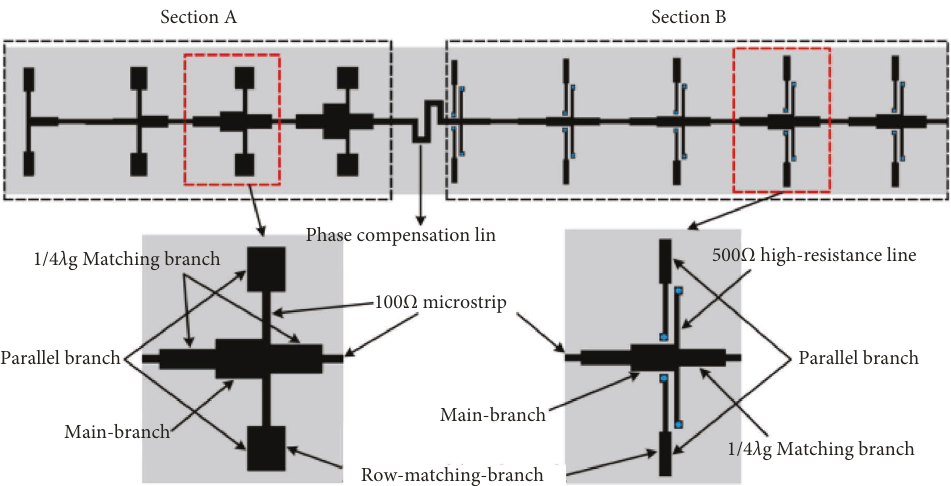
Figure 8: Configuration of feeding network of half array.